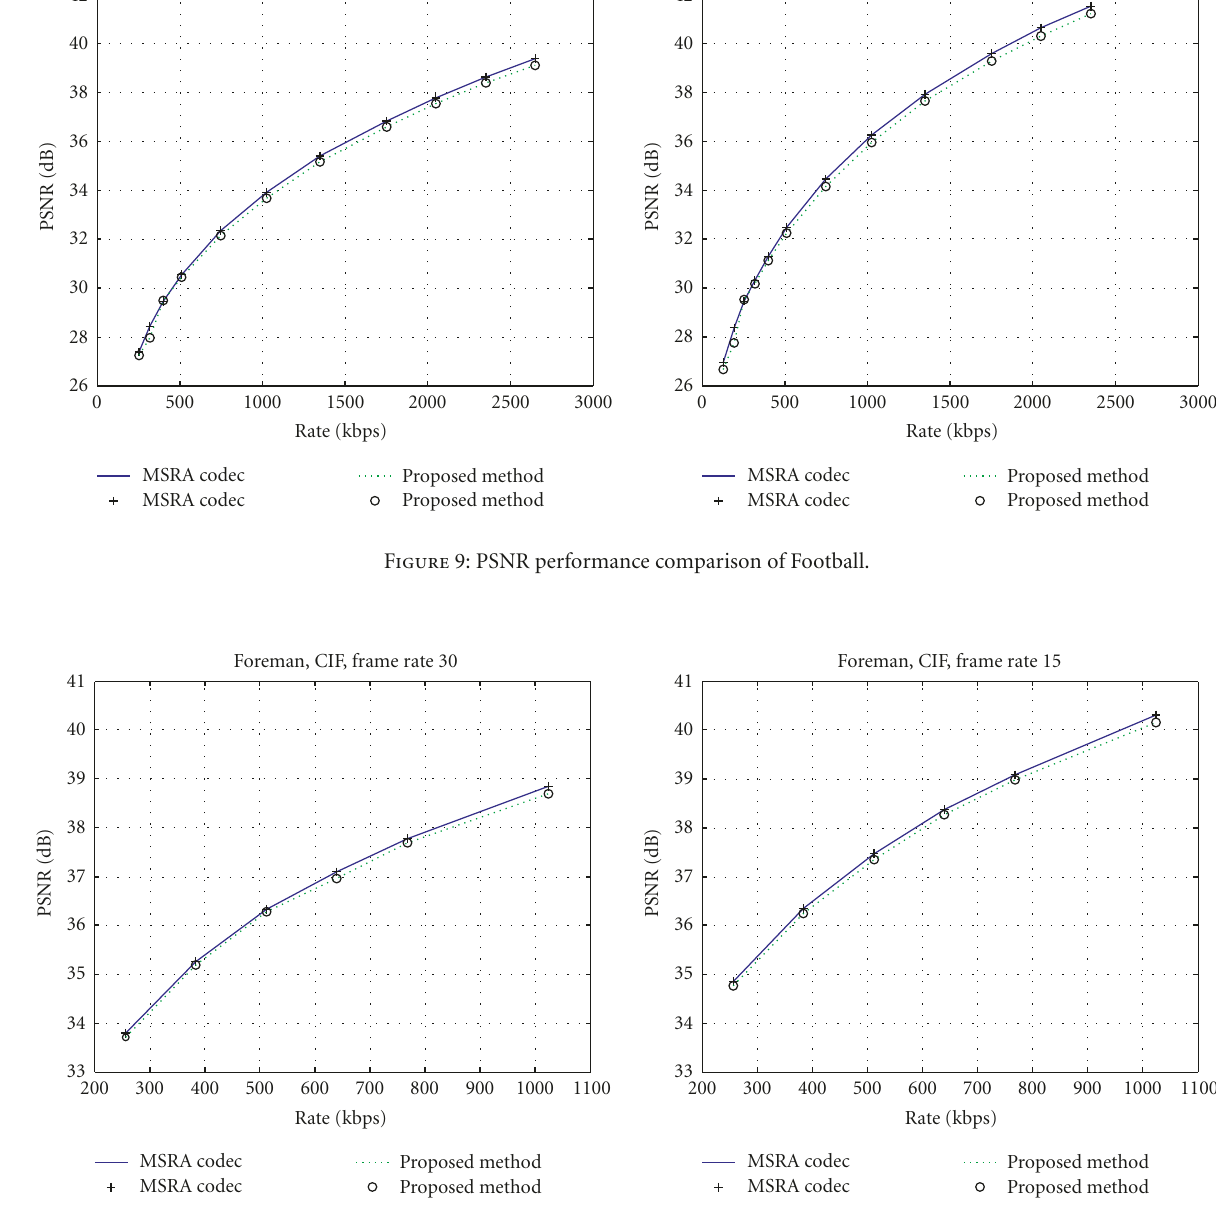
Figure 10: PSNR performance comparison of